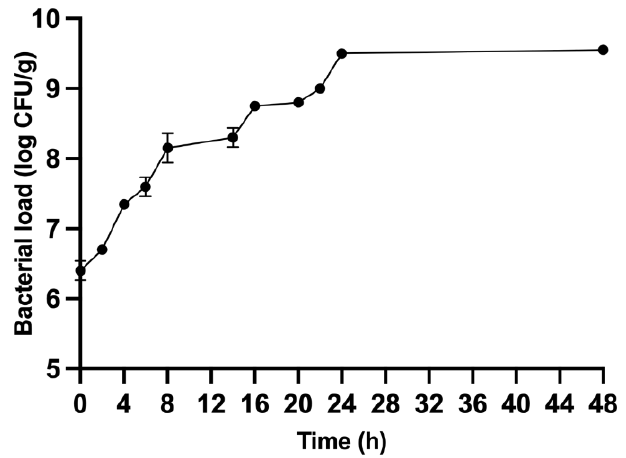
Figure 3. Bacterial growth curve determined during oatmeal fermentation. Each result reported is a mean value of a triplicate analysis and error bars indicate the corresponding standard deviations.